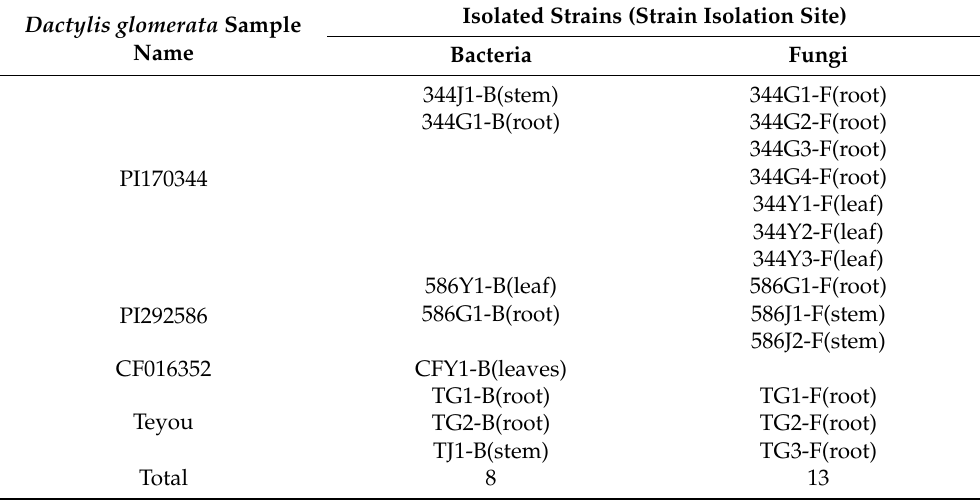
Table 1. Endophytes isolated from different varieties and different parts of Dactylis glomerata . Dactylis glomerata